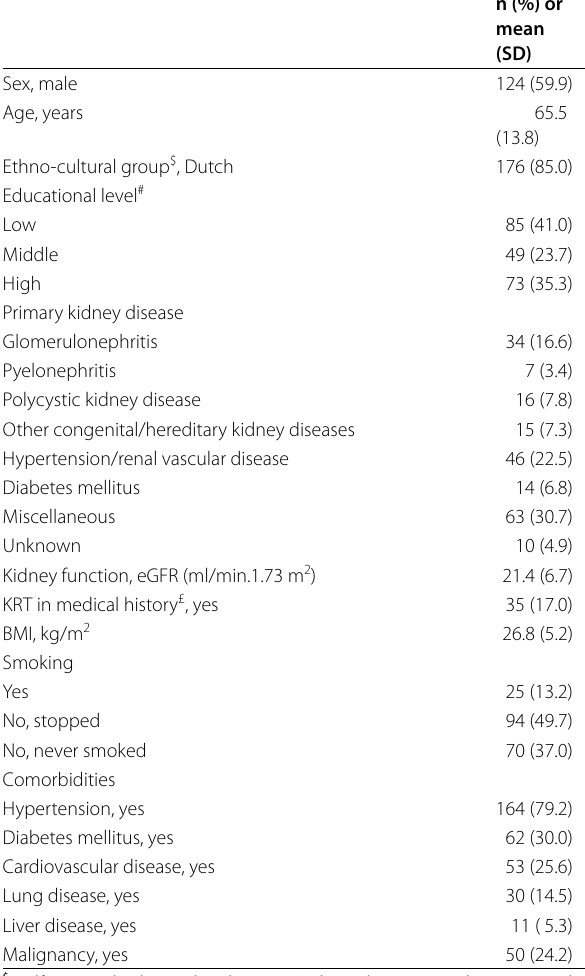
Table 2 Characteristics of the study population at